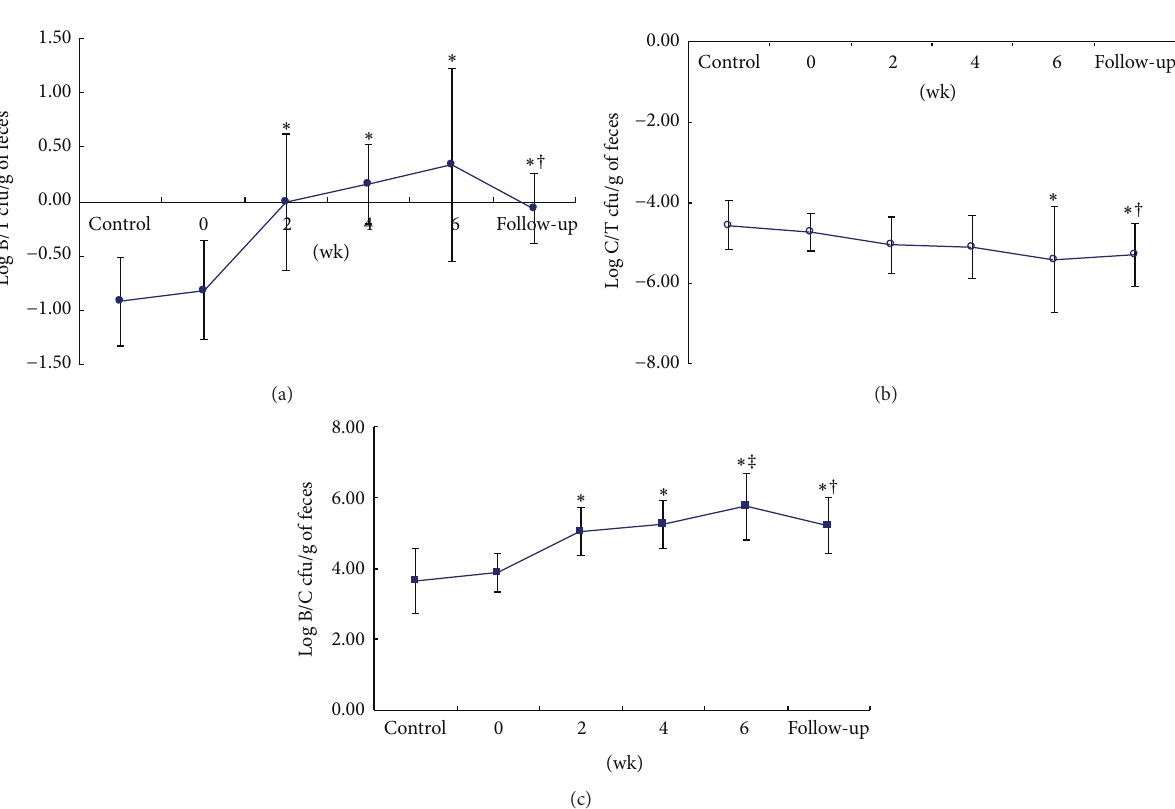
Figure 1: Effect of 3-prebiotic formula administration on the ratio of fecal bacterial flora in healthy subjects. Numbers of Bifidobacterium spp. (B), Clostridium perfringens (C), and total anaerobic bacteria (T) are expressed as log values of colony-forming units (cfu) per gram weight of feces. (a) Log 10 B/T cfu/g wet weight of feces. (b) Log 10 C/T cfu/g weight of feces. (c) Log 10 B/C cfu/g wet weight of feces. In the control period and follow-up period, the control formula was used and not the 3-prebiotic formula. ∗ Values significantly differ compared to that of week 0 of the administration period ( 𝑝 < 0.05 ). † Values significantly differ compared to that of the control period ( 𝑝 < 0.05 ). ‡ Values significantly differ compared to that at week 2 of the administration period ( 𝑝 < 0.05